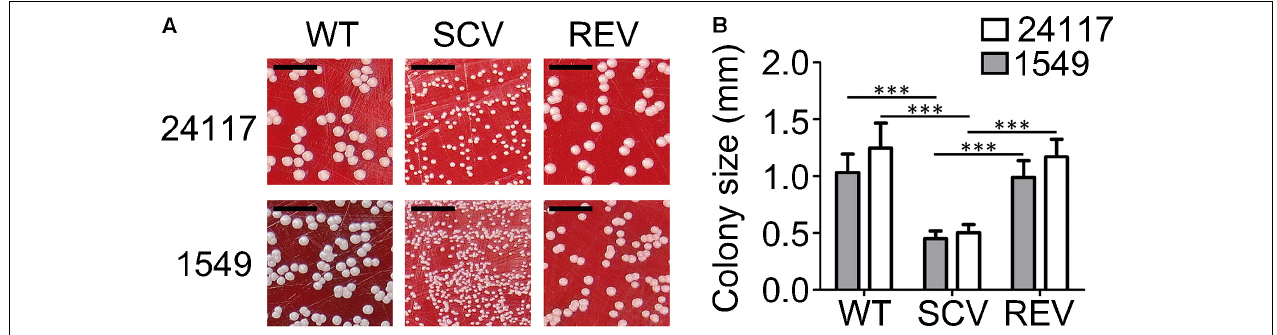
FIGURE 1 | (A) Clinical S. aureus strain triplets 1549 and 24117 each comprising isogenic wild-type (WT), small-colony variant (SCV), and revertant (REV) phenotypes after 24 h of incubation at 37 ◦ C on Columbia blood agar with 5% sheep blood; scale bar indicates 5 mm. (B) Colony sizes of WTs, SCVs, and REVs